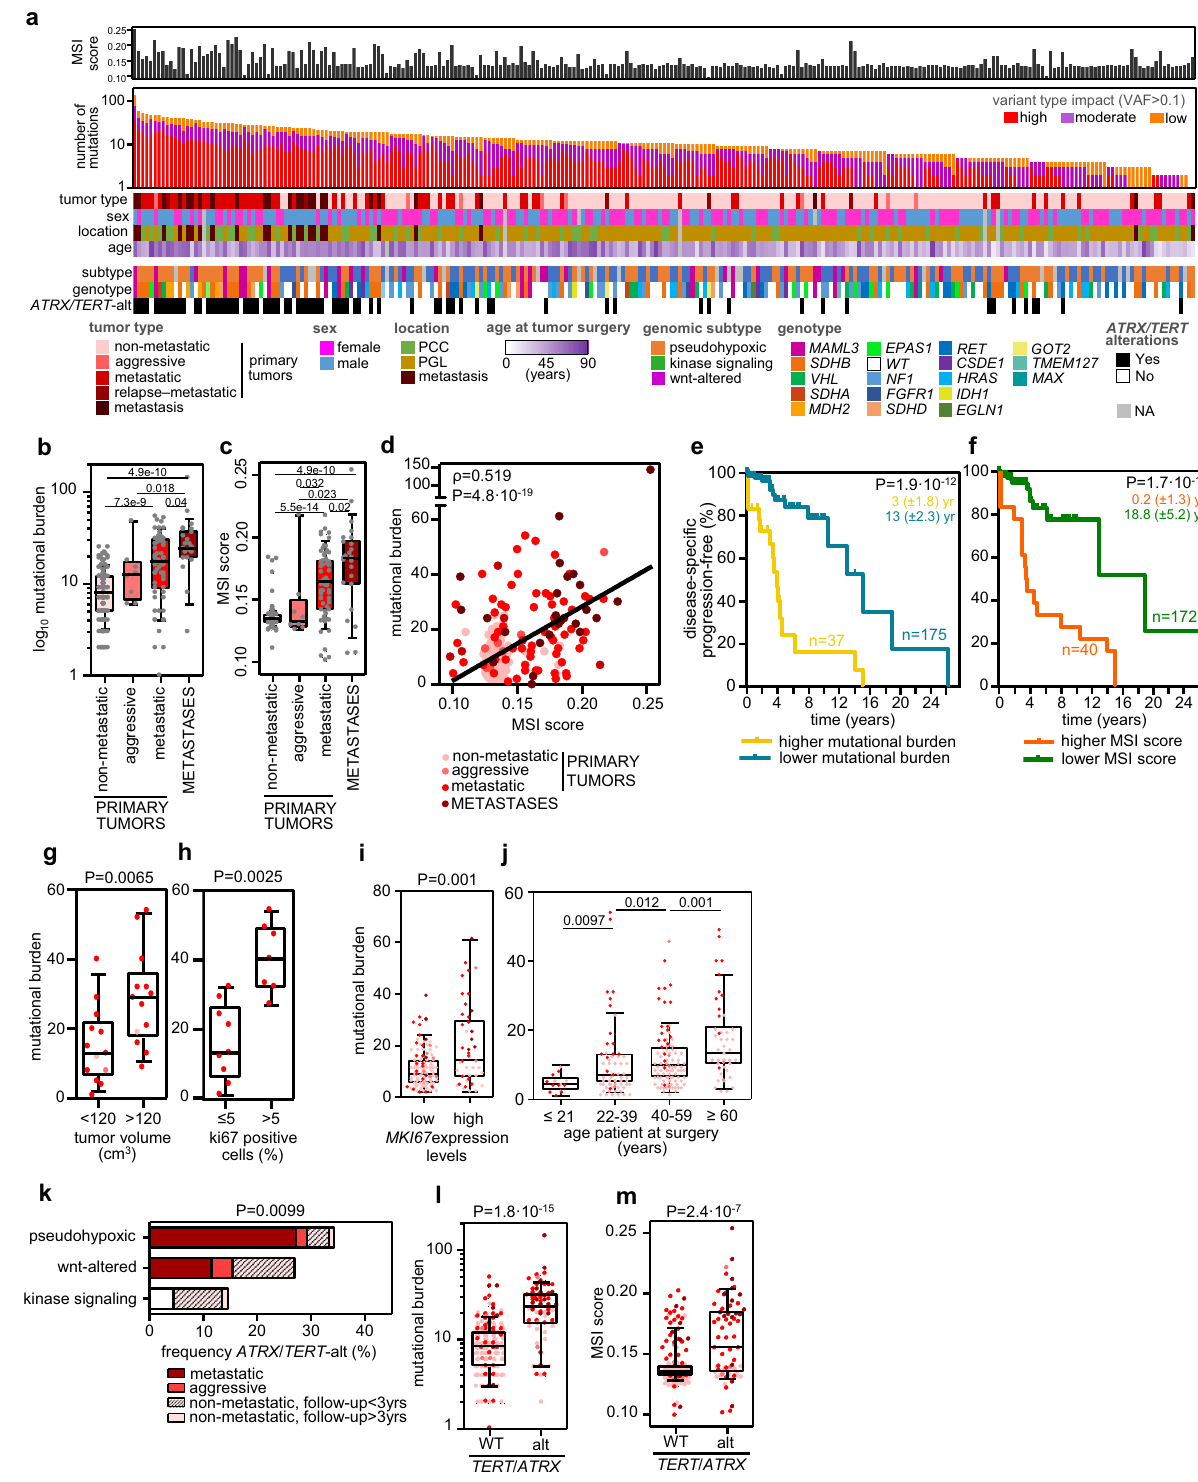
( C5orf49 , DNASE1L3 , HMGB3 , RRM2 , CDT1 , TTC9 , CCNB2 , IQGAP3 , FAM83H , CDK1 , PBK , NETO2 , CSMD2 and PMAIP1 ) (Supplementary Fig. 5b). Functional enrichment analysis of this gene signature using STRING v11 21 indicated a signi fi cant overrepresentation (PPI enrich- ment P =3.08×10 − 7 )ofgenesrelatedtomitoticcellcycle,G1/S-speci fi c transcription, p53 signaling and DNA damage response (Supplemen- tary Fig. 5c). CDK1 , the only gene included in the 4 enriched gene sets, displayed the most signi fi cant association with metastatic risk in a